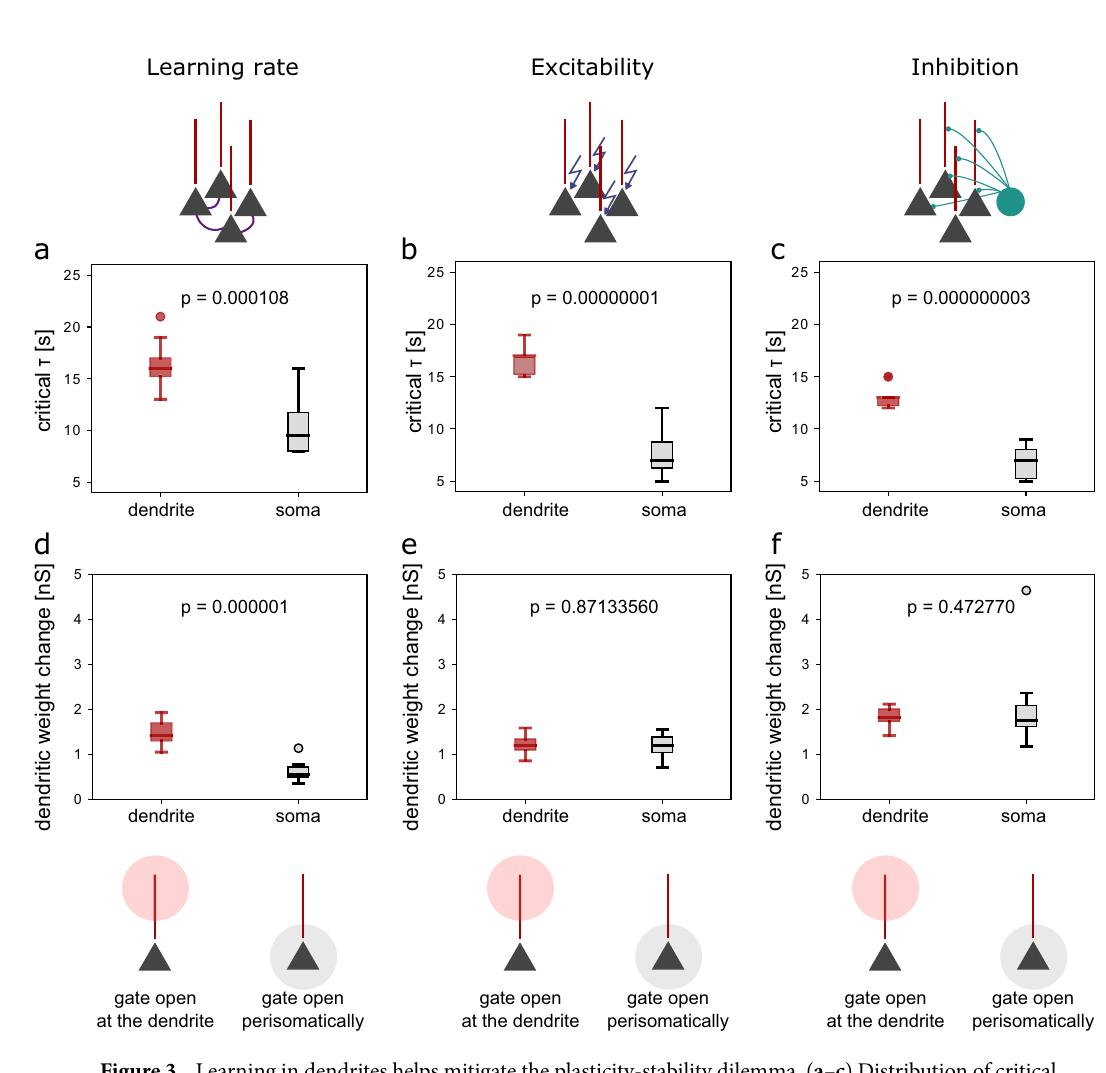
Figure 3. Learning in dendrites helps mitigate the plasticity-stability dilemma. ( a – c ) Distribution of critical homeostatic time constants for gating in the dendritic (red) and in the perisomatic (black) synapses for ( a ) a two-fold increase in the learning rate, ( b ) a 15% increase in excitability and ( c ) a 30% decrease in inhibition. ( d – f ) Distribution of dendritic weight changes for gating in the dendritic (red) and in the perisomatic (black) synapses for ( d ) a two-fold increase in the learning rate, ( e ) a 15% increase in excitability and ( f ) a 30% decrease in inhibition. The rectangles represent the interquartile range (IQR) between first and third quartiles. The thick horizontal lines represent the medians. The whiskers indicate the lowest and highest values within 1.5xIQR from the first and third quartiles, respectively. The circles denote outliers. All p-values were obtained by using the two-sample student’s